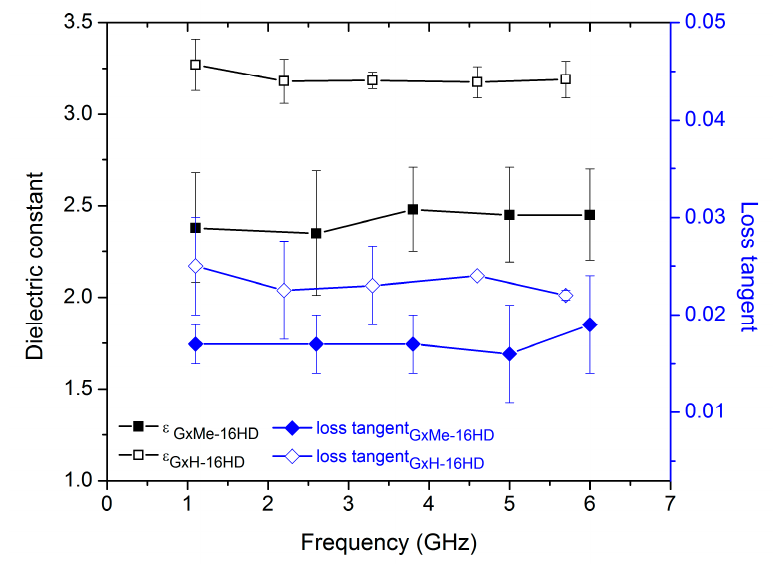
Figure 9. Relative dielectric constant and loss tangent of GxMe-16HD and GxH-16HD samples determined as function of a frequency sweep between 1 and 7 GHz.